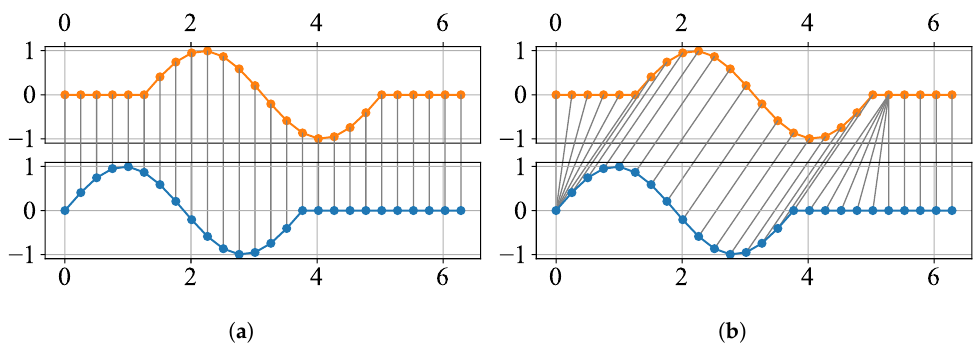
Figure 12. Different methods to evaluate the distance between two time series data. ( a ) Euclidean distance; ( b ) DTW alignment.